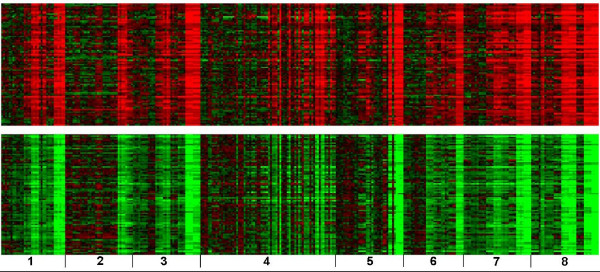
Heat maps of two biclusters containing samples from all exposures and genes correlated with ALT. The red color indicates up-regulation and the green color down-regulation. (A) 87 genes up-regulated in the top half and (B) 86 genes down-regulated in the bottom half were significantly correlated and anti-correlated to the ALT profile respectively. From left to right are (1) 1,2-dichlorobenzene, (2) 1,4-dichlorobenzene, (3) bromobenzene, (4) diquat dibromide, (5) galactosamine, (6) monocrotaline, (7) N-nitrosomorpholine and (8) thioacetamide. Each chemical has its dose exposure from low (left) to high (right). Each chemical dose has its time duration from 6 (left), 24 (middle), to 48 hrs (right).